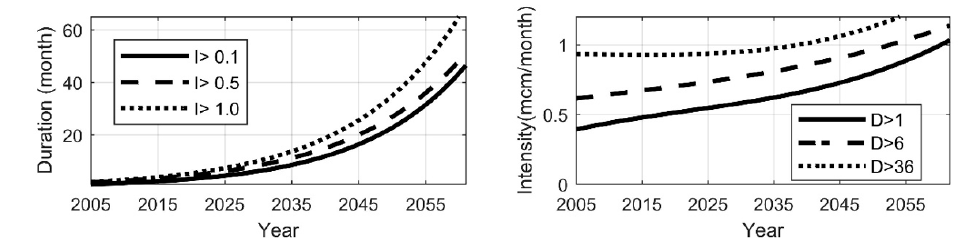
Figure 10. Change in drought durations ( left ) and intensities ( right ) (intensity is in mcm/month).